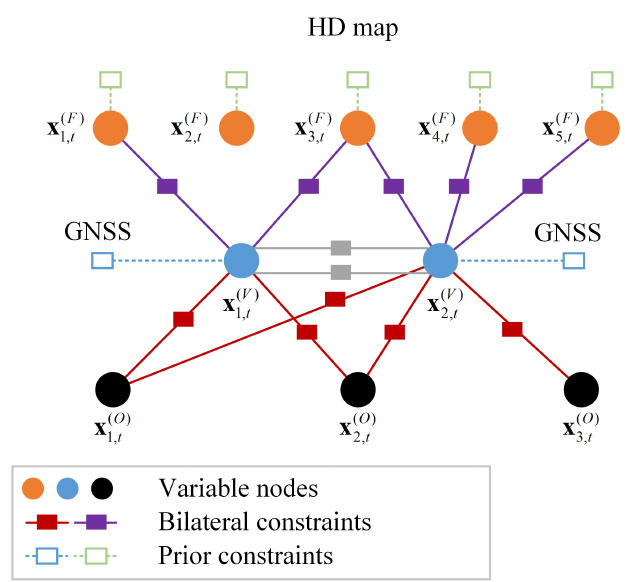
Figure 2. The proposed framework interpreted as inference on factor graphs.